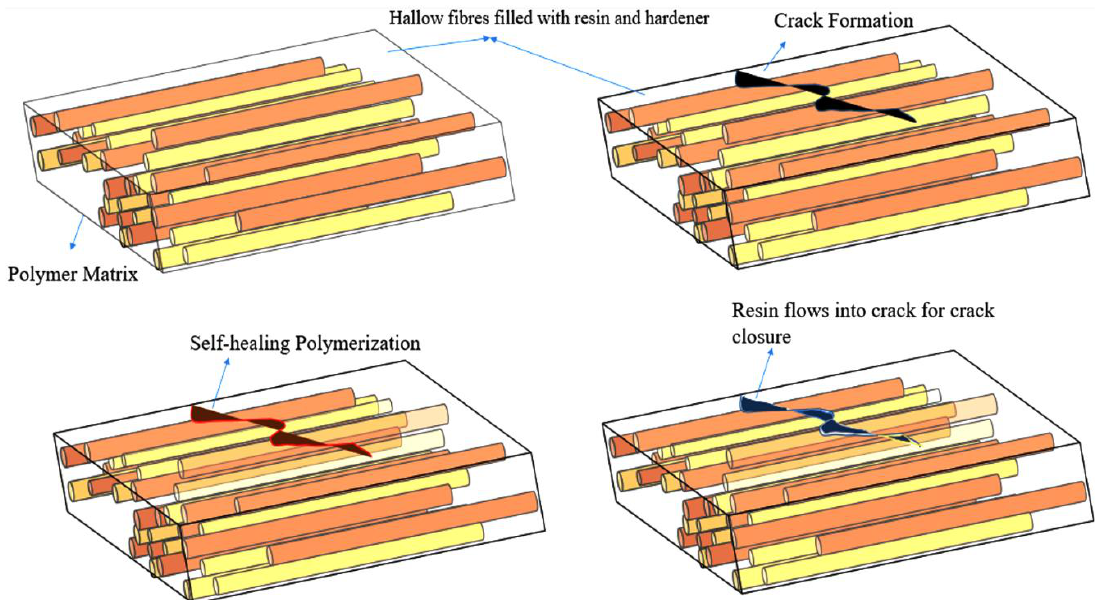
Figure 4. Self-healing of Hollow fibers